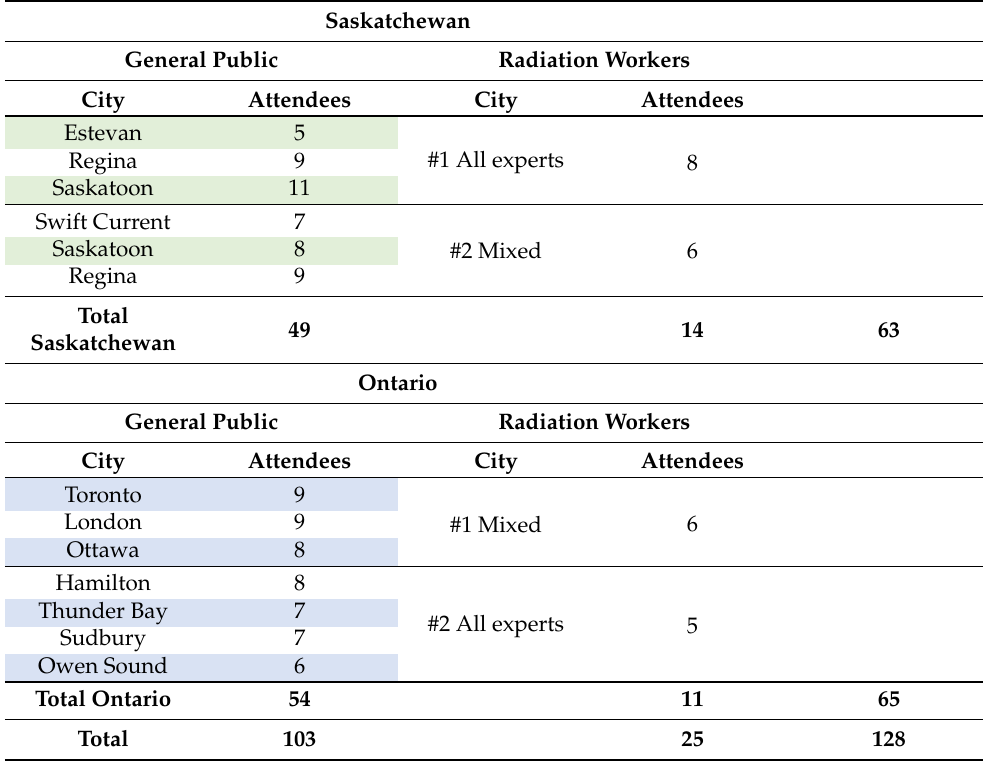
Table 1. Demographics of focus group